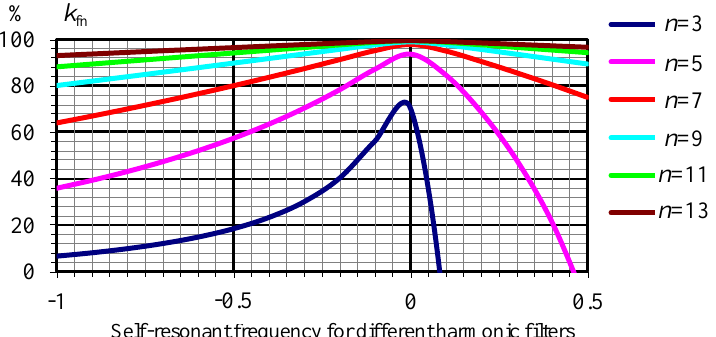
Figure 3. Filtering out higher harmonics as a function of the departure of the self-resonant frequency from the order of the filtered harmonic, subject to the self-resonant frequency of the applied filter ( n - n r ).